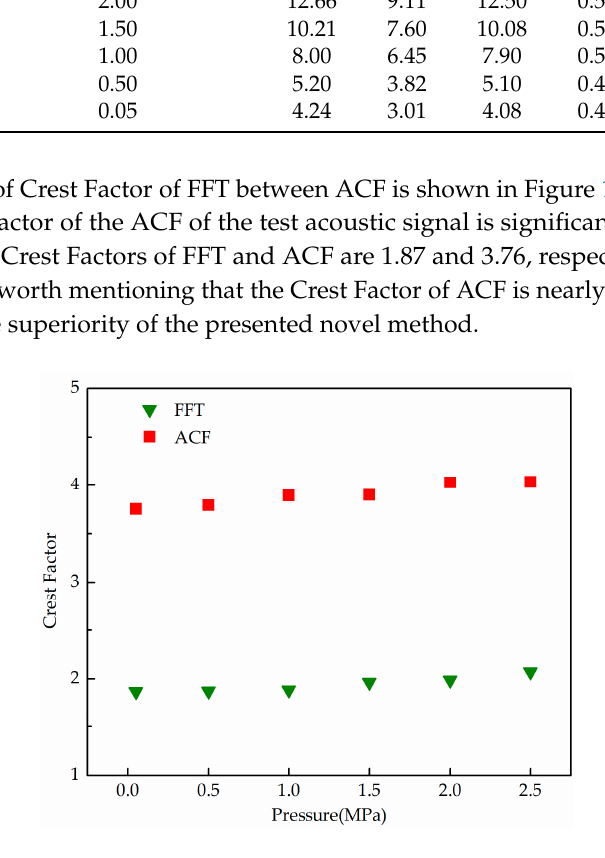
Figure 11. Comparison of Crest Factor of the signal between FFT and ACF under different annulus pressures.